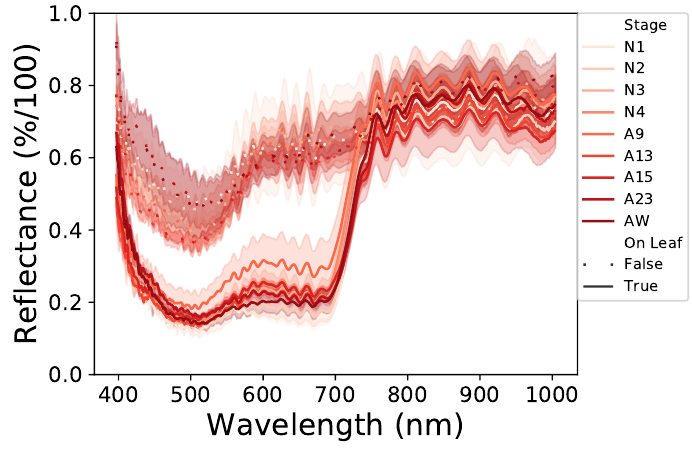
( b ) White–dark normalized spectra of A. pisum YR2 (pink aphids).